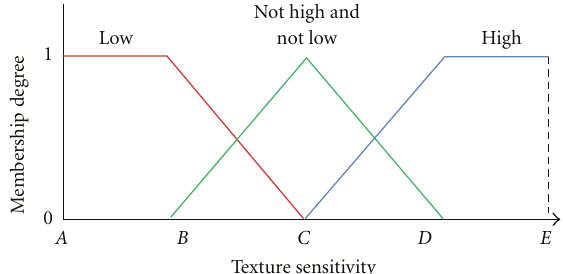
Figure 2: Dynamic membership function for texture